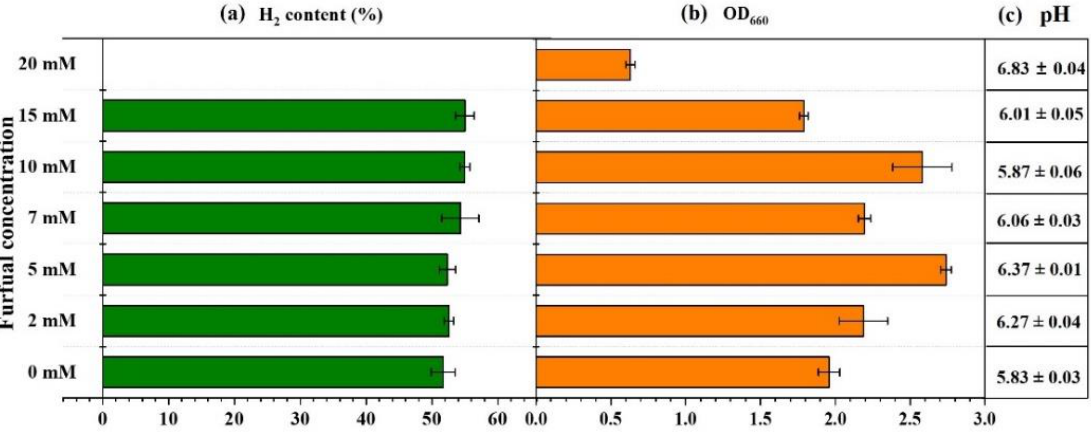
Figure 3. Overall H 2 content ( a ), final cell concentration (OD 660 ) ( b ), and final pH values ( c ) for photo- fermentations with glucose in the presence of furfural.